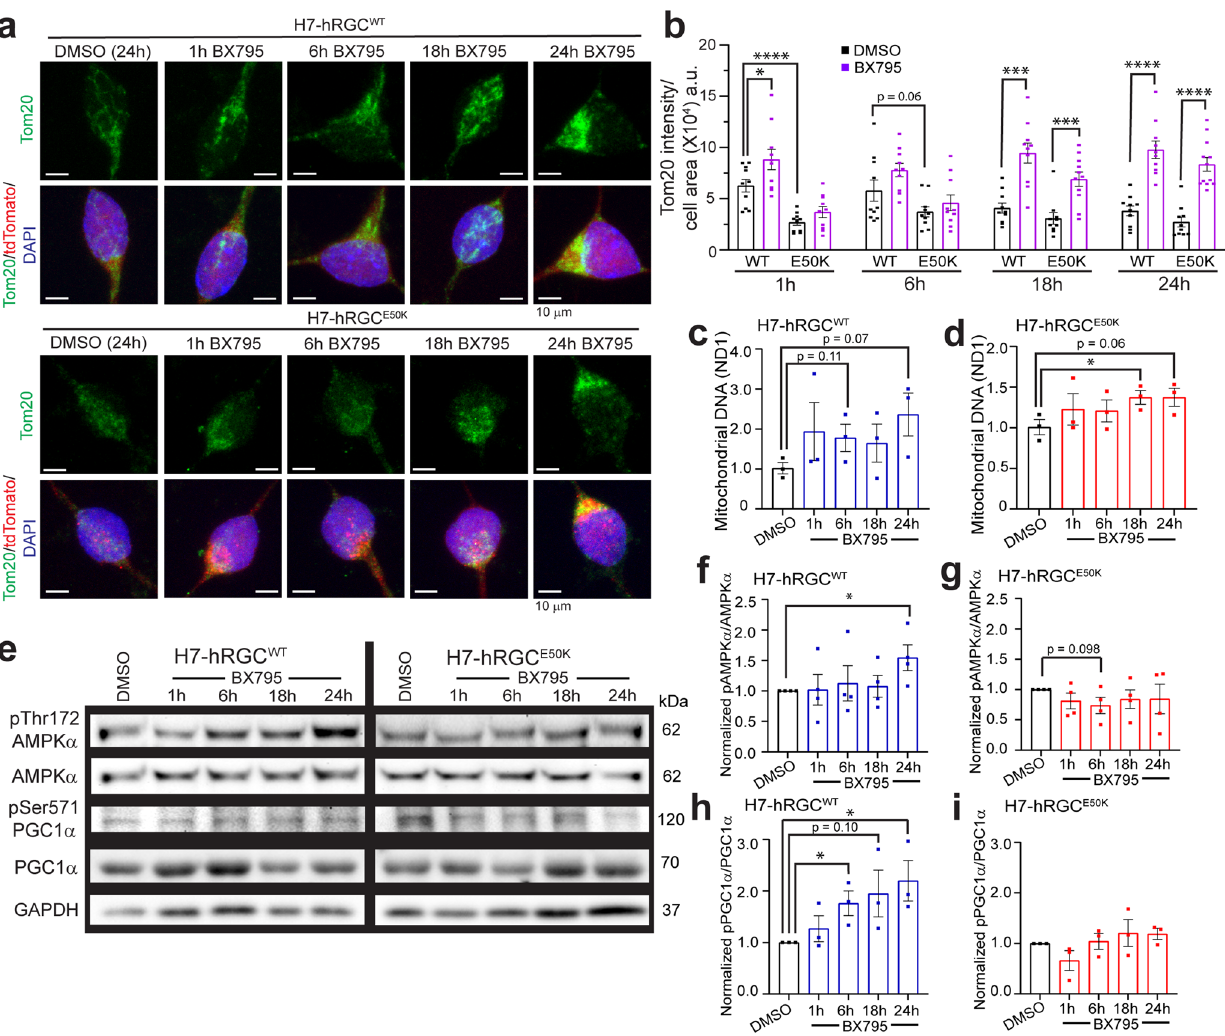
Fig. 4 TBK1 inhibition activates mitochondrial biogenesis in hRGCs. a Representative confocal immuno fl uorescence images of mitochondria (Tom20), tdTomato, and DAPI after 1 μ g/ml BX795 or equivalent DMSO treatment for the indicated time. Scale bars are 10 μ m. b Quanti fi cation of Tom20 intensity per cell area from the sum projections of confocal z-stacks. n = 10 cells per condition. c , d Mitochondrial DNA copy number analyzed by qPCR for mitochondrial ND1 gene normalized to nuclear RNase P gene. Results shown as ΔΔ Ct fold change normalized to DMSO control for different times points of 1 μ g/ml BX795 treatment. n = 3, 3 technical repeats averaged for each biological repeat. e Representative western blot images of H7-hRGCs treated with 1 μ g/ml BX795 for indicated timepoints. f – i For each protein, band intensities were quanti fi ed and fi rst normalized to corresponding GAPDH loading control, then to its DMSO values, f , g ratio between p-AMPK α Thr172 to AMPK α , and h , i ratio between p-PGC1 α Ser571 to PGC1 α . n = 3-4. ٭ p -value < 0.05, ٭٭ p -value < 0.01, ٭٭٭ p -value < 0.001, ٭٭٭٭ p -value < 0.0001. Unpaired student ’ s t- test between DMSO and the individual BX timepoints. Error bars are